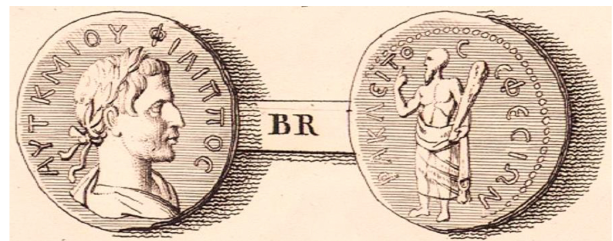
Figure 5. (Heraclitus of Ephesus; c. 535– c. 475BC), Ionian philosopher, father of dialectics, depicted in the back facet of a coin whose front facet shows Philip (image source: Visconti,